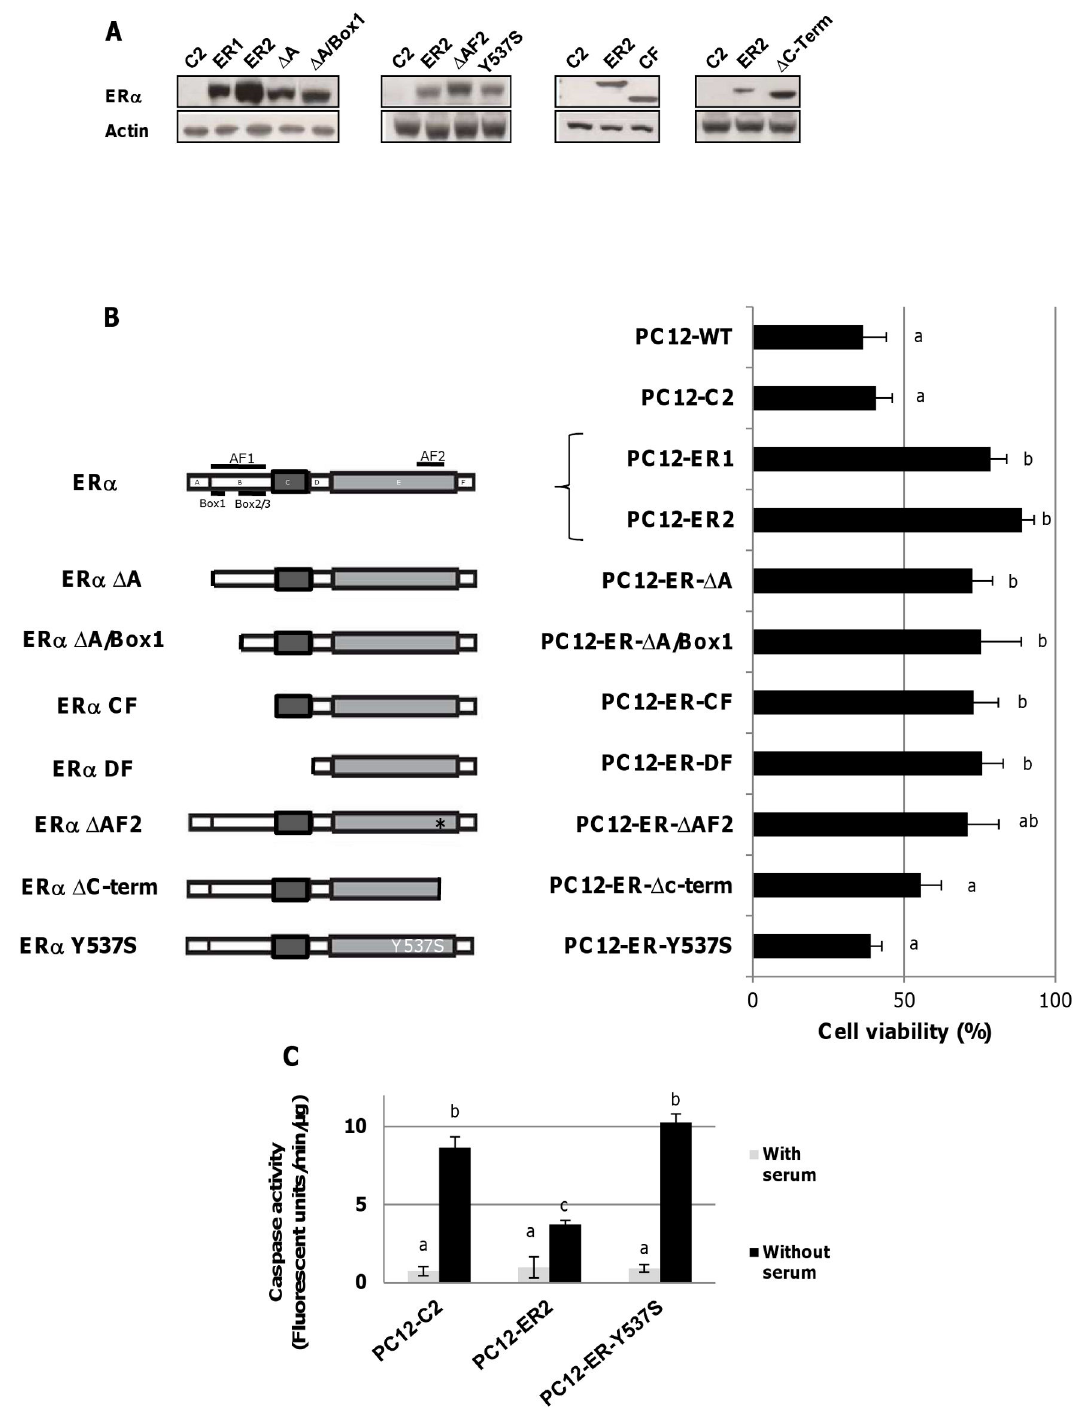
Figure 2. Ligand-independent protection against apoptosis depends on tyrosine 537 of ERα. A) - Total protein was extracted from different PC12 clones and the level of ERα was analyzed by Western blotting. B) - Cell viability (right panel) of mutated PC12 clones (left panel) was determined after 24 hrs of serum deprivation using ViaLight HS kit (Lonza). For each clone, viability was expressed in percent in reference to the viability of the same clone maintained in medium containing 5% charcoal stripped serum (value 100). Values correspond to the mean ± SEM of at least three separate experiments. Columns with different superscripts differ significantly (p<0.05 by Student test). doi: 10.1371/journal.pone.0069081.g002 PLOS ONE |